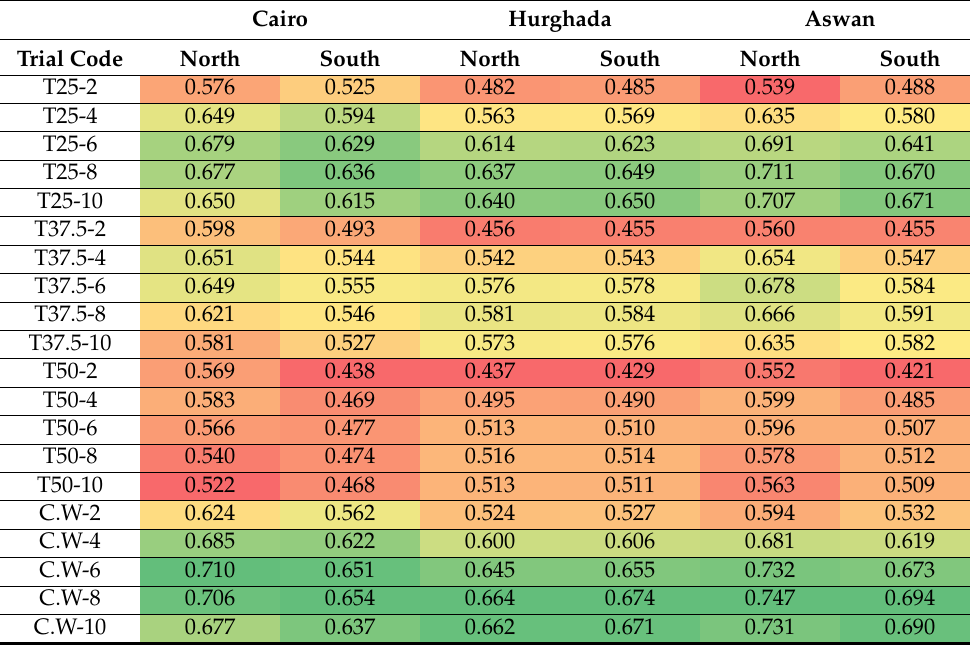
Table 6. The scores for all opaque alternatives in the energetic